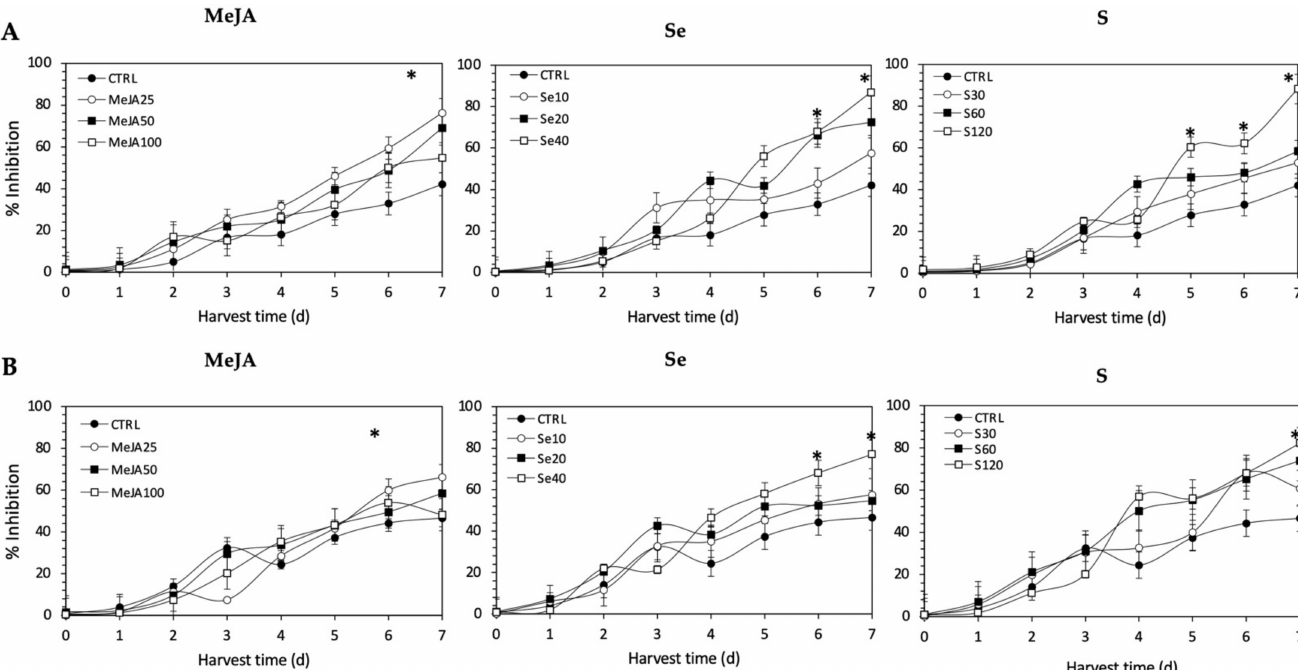
Figure 12. Nitric oxide scavenging activity of ethanolic extract of ( A ) Red Russian and ( B ) Dwarf Green kale sprouts treated with (1) methyl jasmonate, (2) selenium, and (3) sulfur during the first 7 days of germination. Bars are means of 3 replicates ± standard error. Abbreviations: methyl jas- monate (MeJA), sulfur (S), selenium (Se), harvest time (HT). Data points with an asterisk “*” indicate statistical difference determined by a t -test ( p < 0.050) between the control and treated